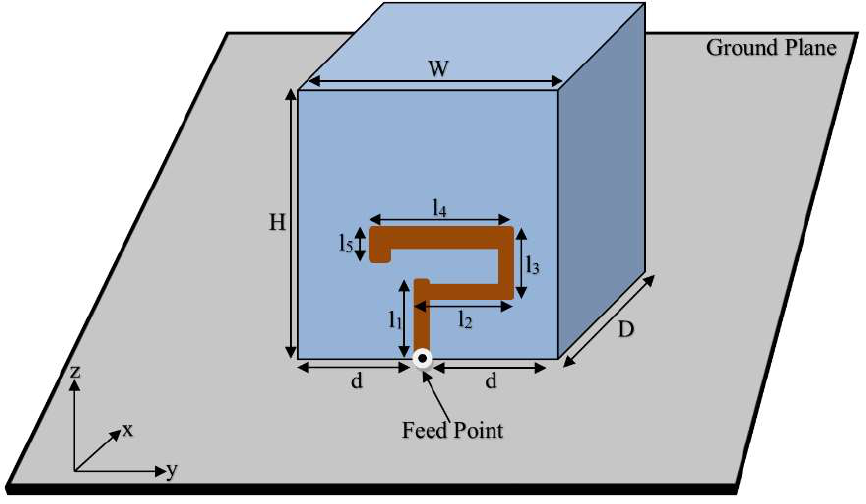
Figure 1. The geometry of the proposed CP 5G RDRA.